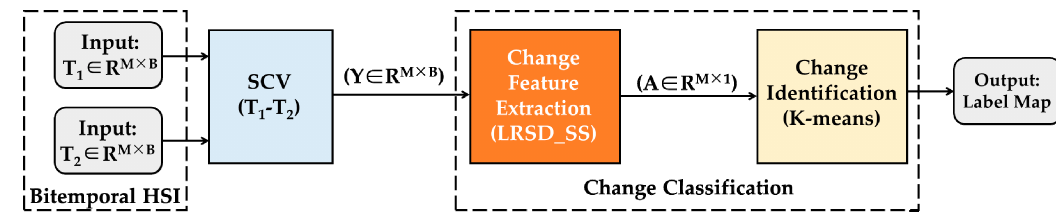
Figure 1. A framework for change detection in HSI, where T 1 ∈ R M × B and T 2 ∈ R M × B are bitemporal hyperspectral images acquired at time 1 and time 2, respectively; Y ∈ R M × B is SCV of T 1 and T 2 ; and A ∈ R M × 1 is amplitude vector of change features.